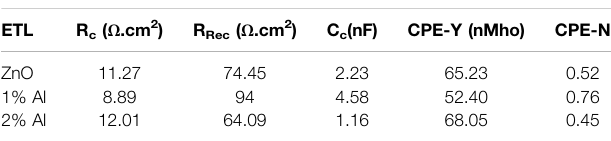
EIS data is given in Table 3 .